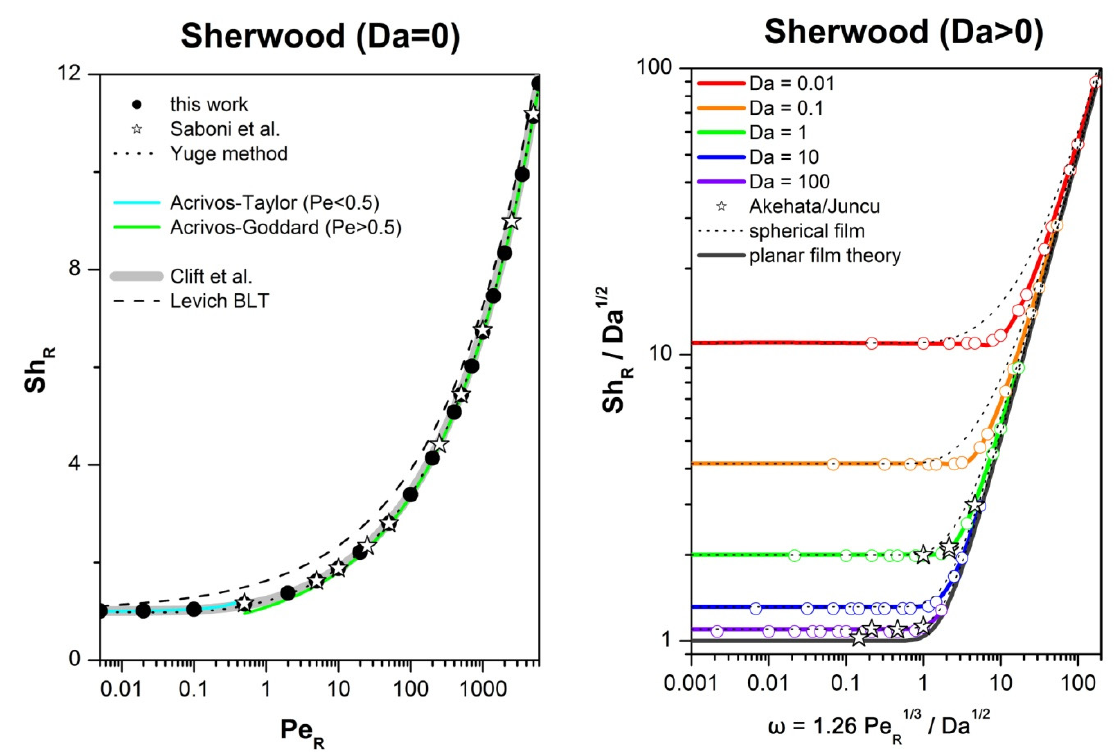
Figure 3. Validation of the numerical model against published data for the radius-based Sherwood number, as a function of the Péclet and Damköhler numbers within the range defined in Table 1. For zero consumption (Da = 0), our calculations are in excellent agreement with numerical data and correlations from the literature [53,56–59]. For finite consumption (Da > 0), our calculations (circles) are in good agreement with the Yuge approximation (colored lines), numerical data (stars) [54,60], the planar film theory (black line) and the spherical film theory (black dotted lines) [55]. In addition to the correlations given in the main text, we have: Sh R0 = 1 + 0.6245 Pe 1/3 (dashed line [56]), Sh R0 = 0.461 + 0.6245 Pe 1/3 for Pe > 0.5 (green line [57]), and Sh R0 = 1 + 0.5 Pe R + 0.5 Pe 2 ln ( Pe ) for Pe < 0.5 (cyan line [58]).